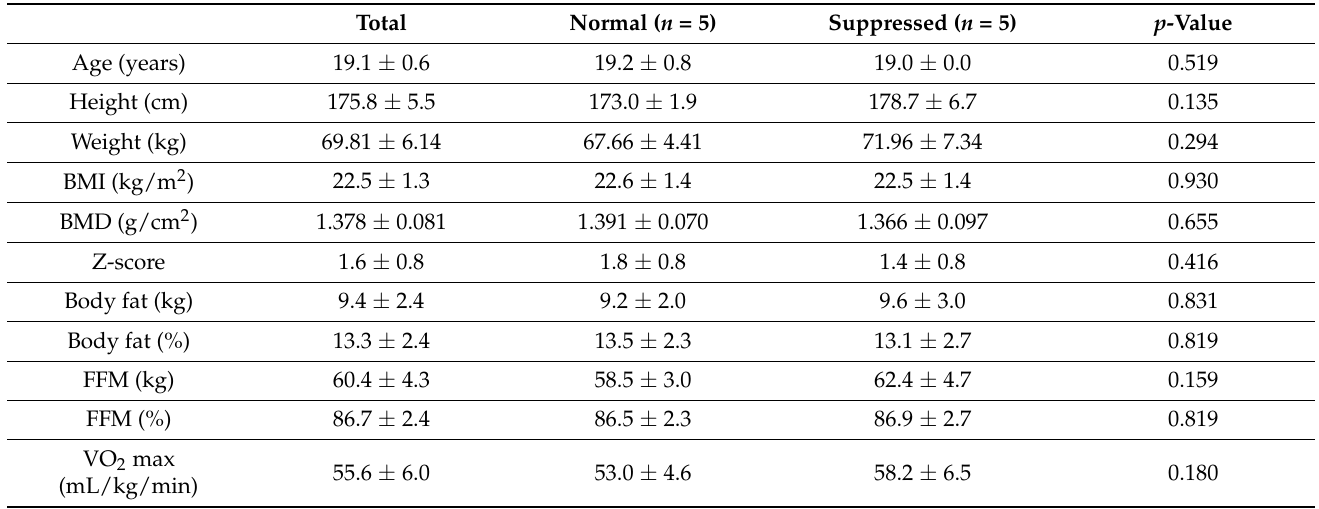
Table 1. Descriptive characteristics of the participants.